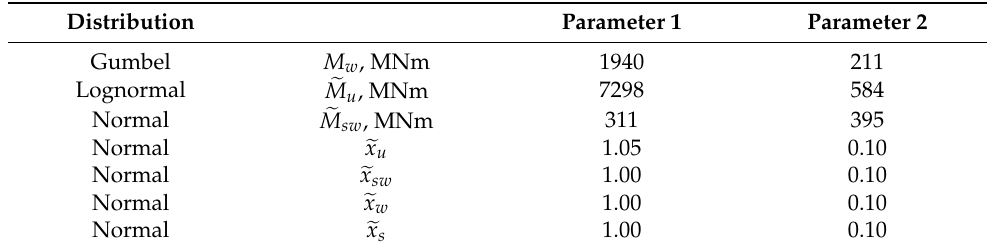
Table 1. Statistical descriptors of limit state function.